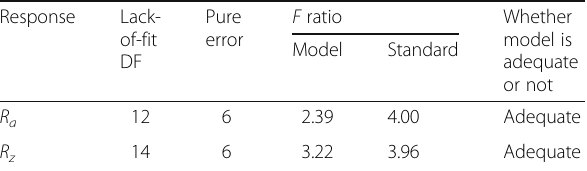
Table 6 Results of ANOVA analysis Response